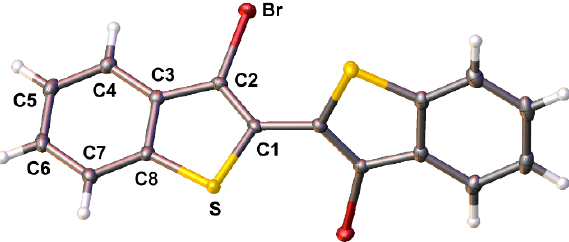
Figure 2. Ellipsoid plot of 3,3 ′‐ dibromo ‐ 2,2 ′‐ bi(benzo[ b ]thiophene) ( 4 ) at the 50% probability level.